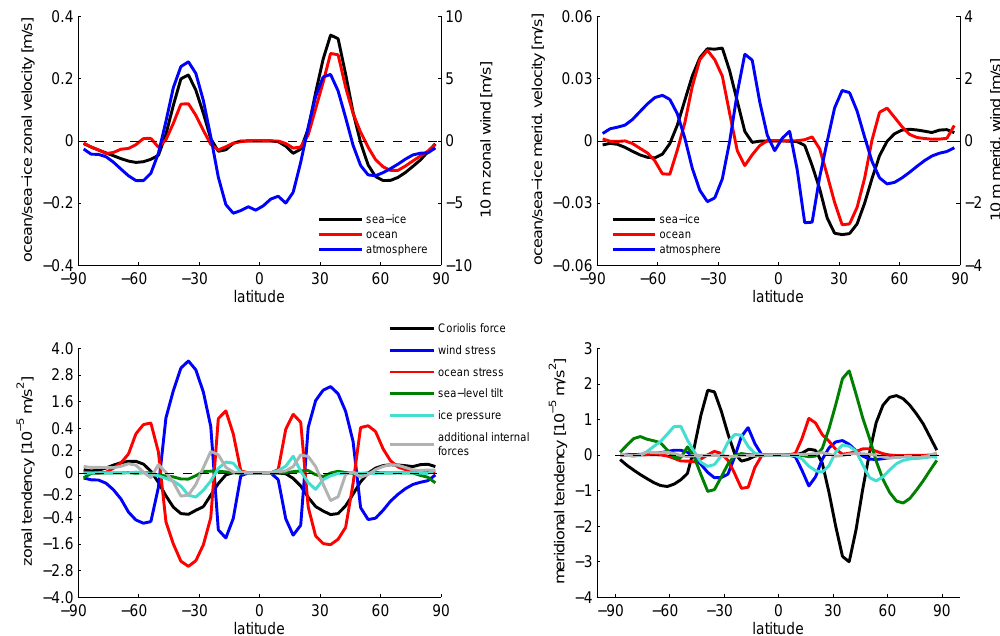
Fig. 7. Analysis of sea-ice velocity tendencies in the CO 2 =209ppm simulation with low bare sea-ice albedo and fully active sea-ice and ocean dynamics. The simulation equilibrates at 70% sea-ice cover. Top row: zonal (left) and meridional (right) velocities of sea ice (black), the surface ocean layer (red), and the 10m wind. For the ocean velocities only sea-ice points are taken into account, which leads to the zero values near the equator. The left y-axis is for the sea-ice/ocean velocities, the right y-axis for the 10m wind. Bottom row: zonal (left) and meridional (right) sea-ice velocity tendencies. Note that for the zonal sea-ice velocity tendencies, the y-axis has a non-linear scaling.